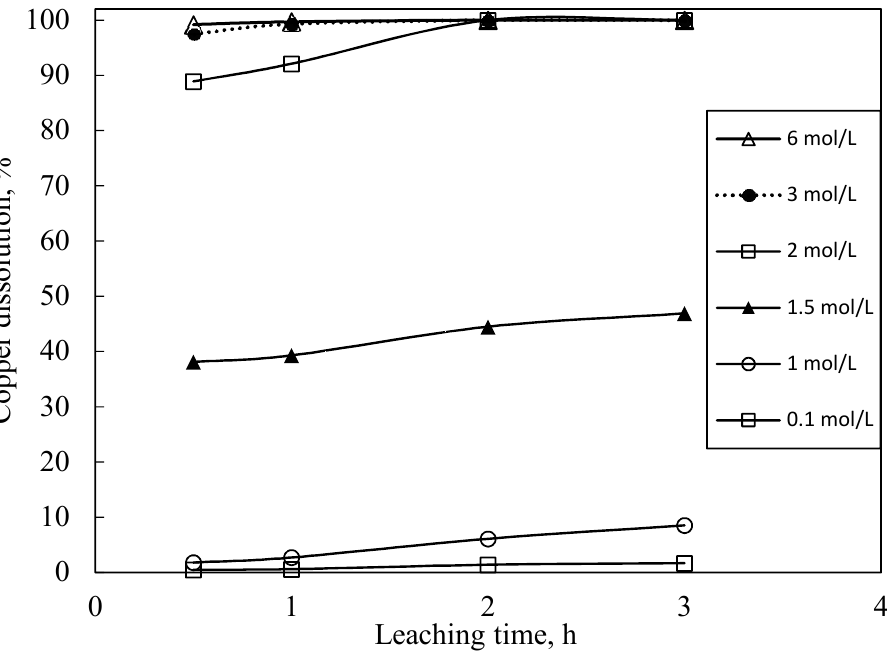
Figure 4. Copper dissolution yields as a function of nitric acid concentration and leach time. H 2 O 2 20% v/v , L/S ratio 10, T 25 °C, particle size −0.5 mm, and stirring 250 rpm.